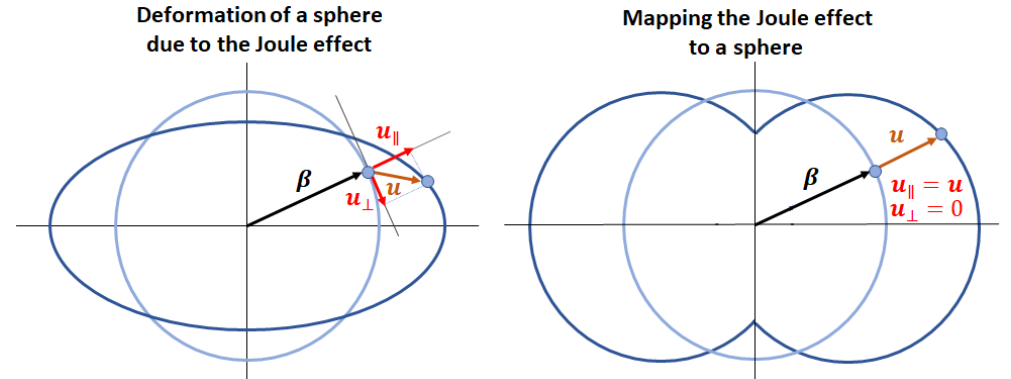
Figure 6. Comparison between the shape deformation of a sphere induced by the Joule effect and the shape generated by mapping the Joule effect to a